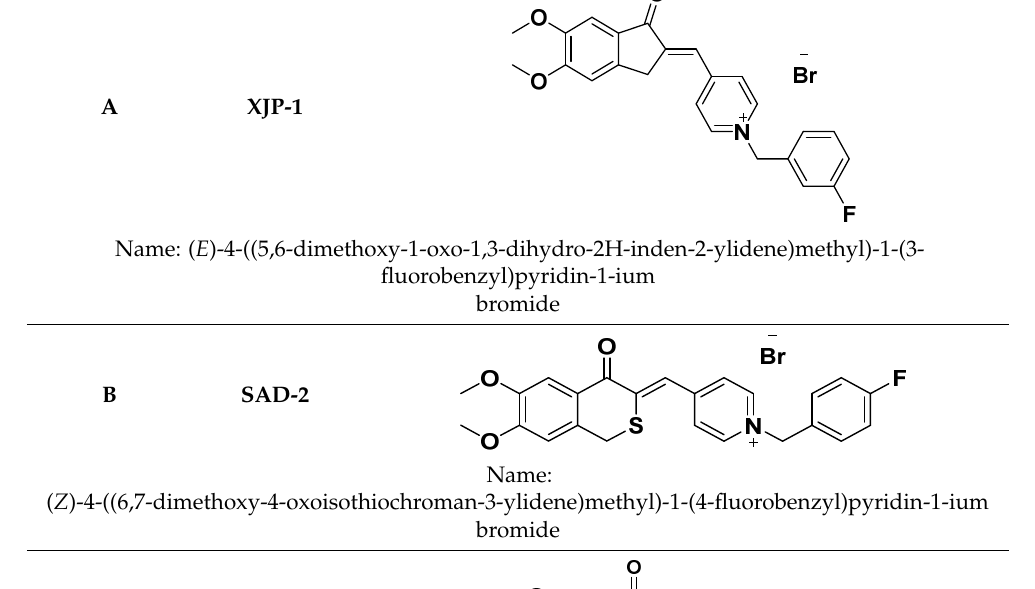
Table 1. Structures of novel compounds . Single AChE inhibitors and dual AChE/GSK-3 inhibitor and IUPAC names. (A) XJP-1. (B) SAD-2. (C) SAD-6. (D) 24r . (E) 27g . No. Compd.